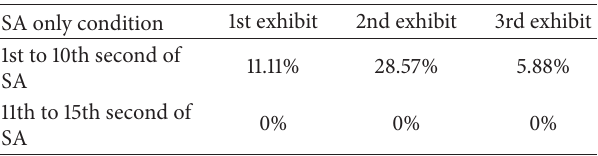
Table 3: Disengagement of the subjects from the exhibits in the LB only